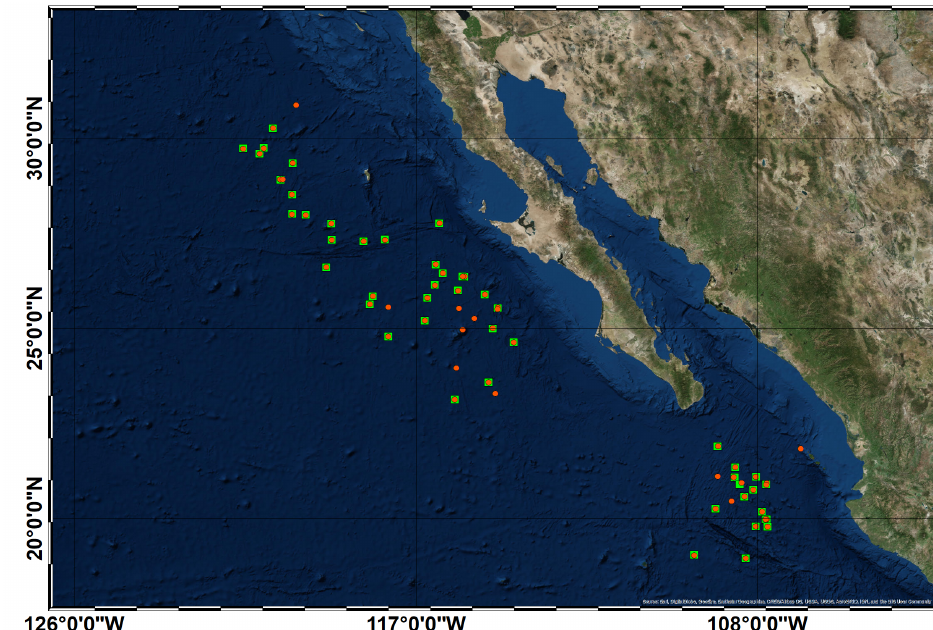
Figure 7. Mexico test case: AIS positions (green squares) and SAR C un − norm circles). The positions correspond to the cumulation of SAR detections for all the Sentinel-1 images of this dataset and their associated interpolated AIS